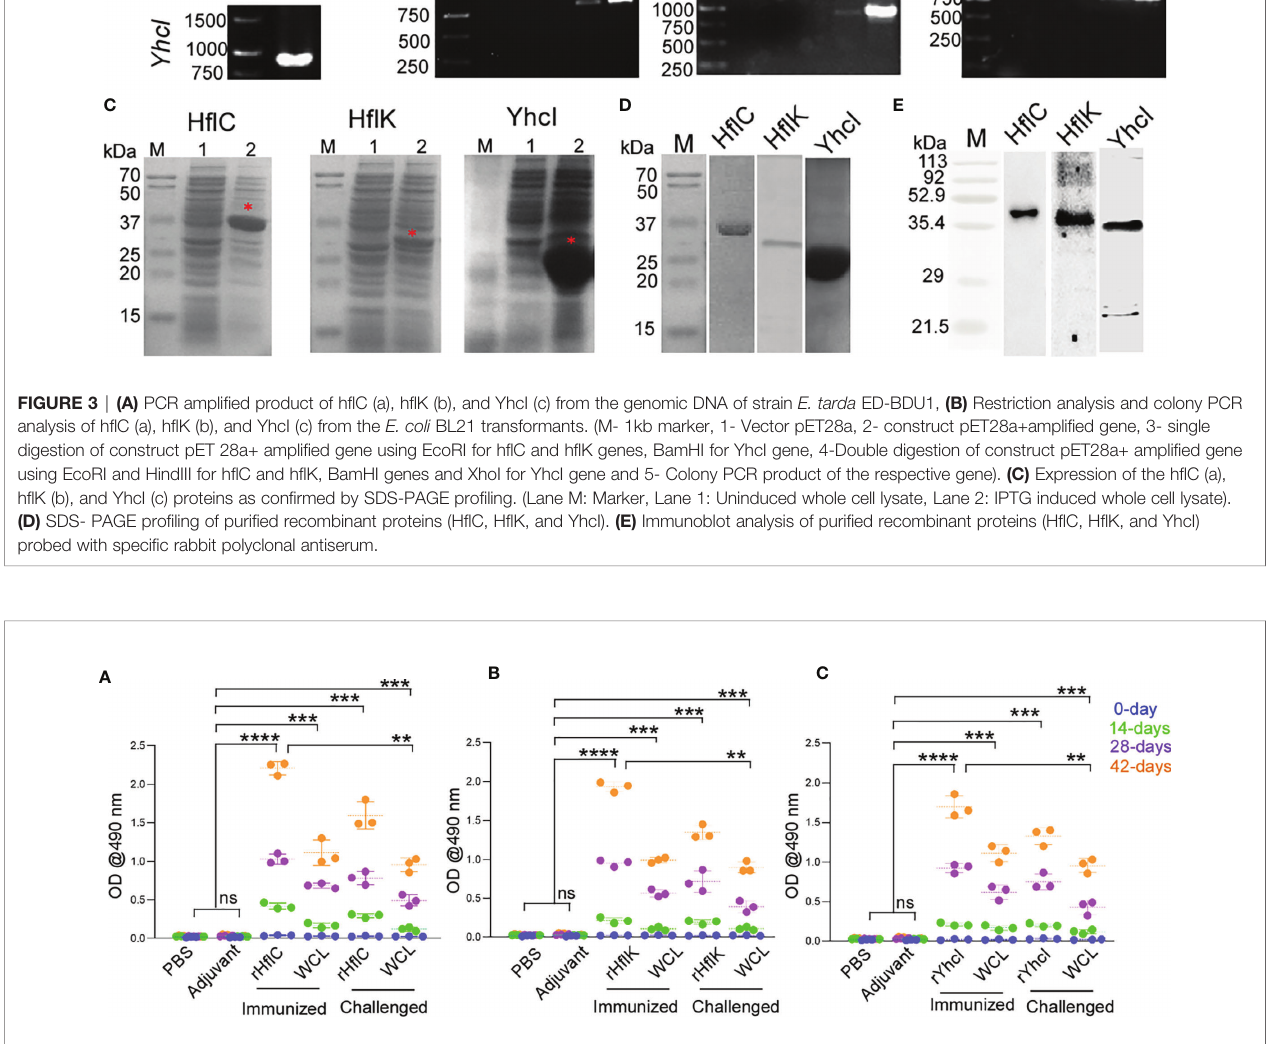
cytokines. Particularly, H fl C based recombinant protein vaccine shows a good level of cytokine induction. Protective Ef fi cacy of Vaccines The LD50 dose was in the range of 1.6×10 5 c.f.u. The protective ef fi cacy of H fl C, H fl K, and YhcI was evaluated in terms of